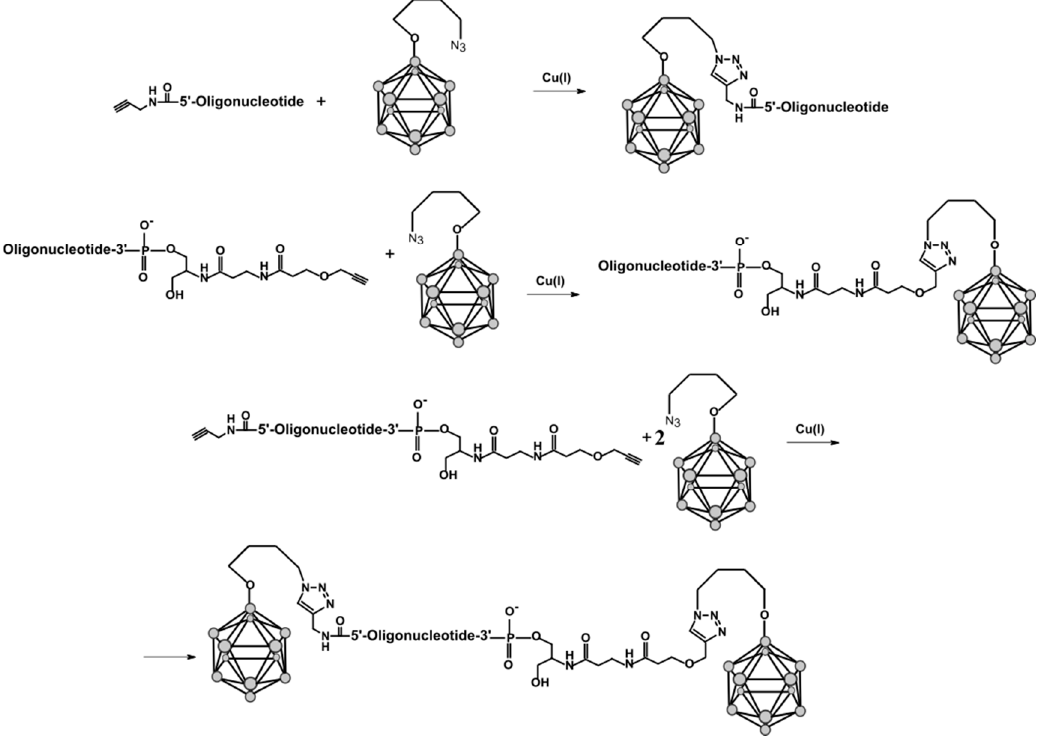
Figure 2. Schemes of the incorporation of closo -dodecaborate azido derivatives into 5 ′ -, 3 ′ - or dual 5 ′ ,3 ′ -alkyne-modified oligonucleotides using click chemistry.